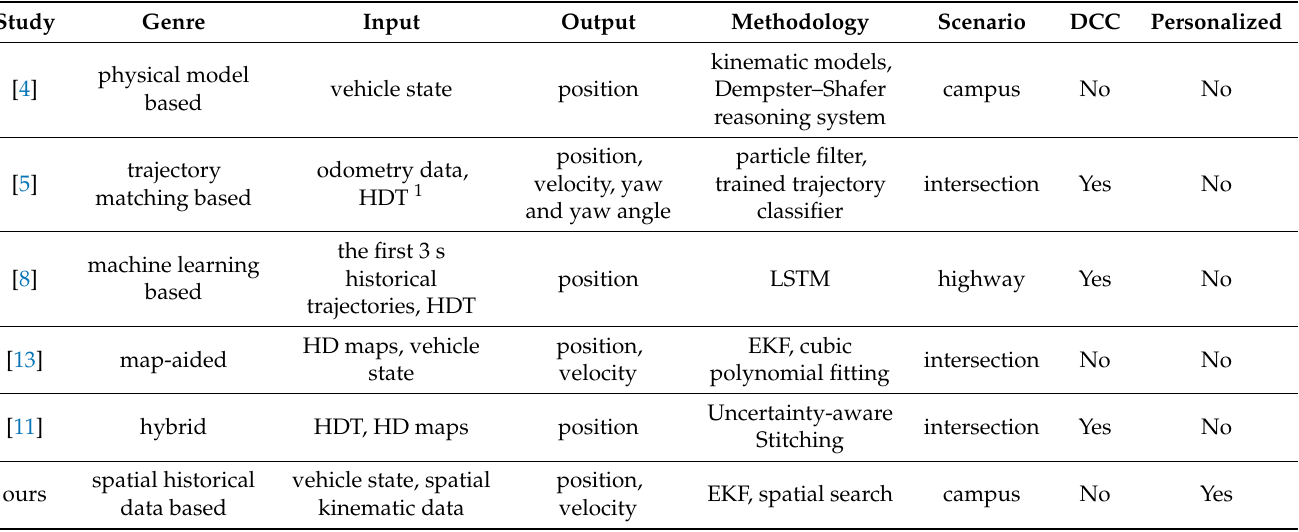
Table 1. A comparison between our method and some typical methods selected from the five genres. The methods with learning/training processes are regarded as DCC.